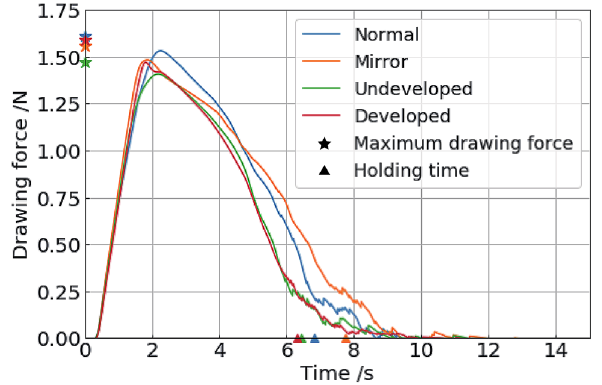
Figure 3. Result of pull-out experiment. Average change with respect to time of the drawing